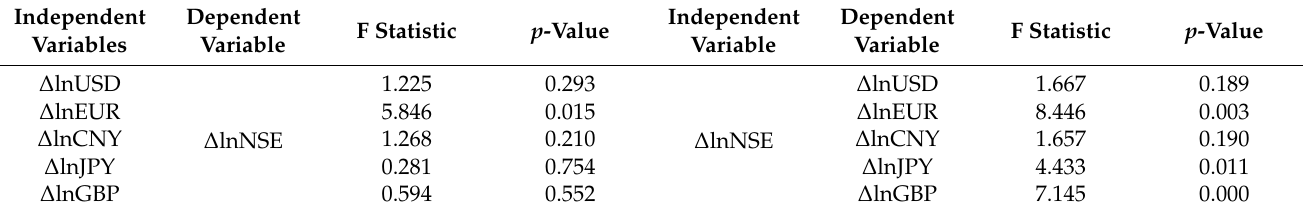
Table 5. Granger causality in VAR Framework for the period October 2009–October 2013.